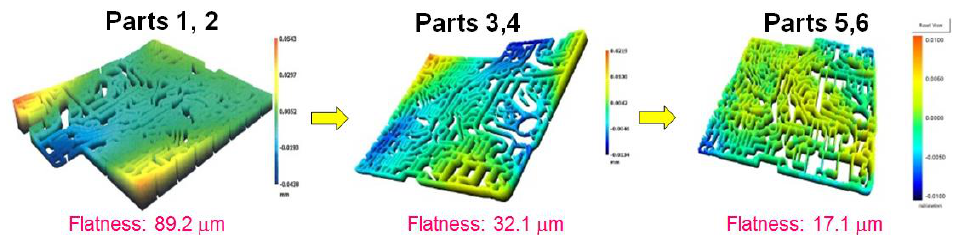
Figure 5. Tool path optimization to shorten product launch period.